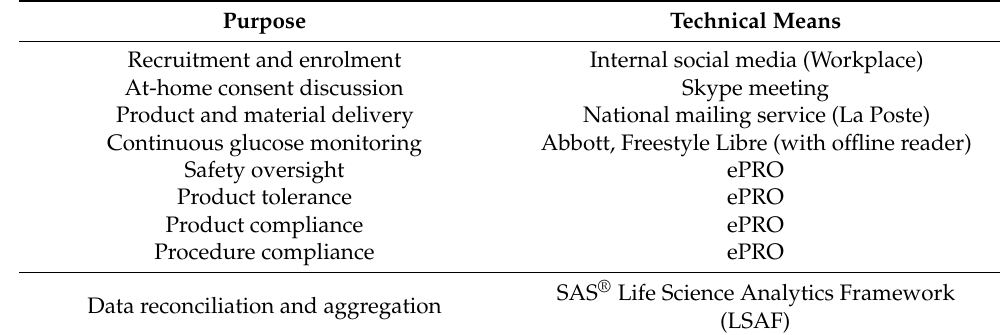
Table 2. Technical means implemented for each purpose of the decentralized